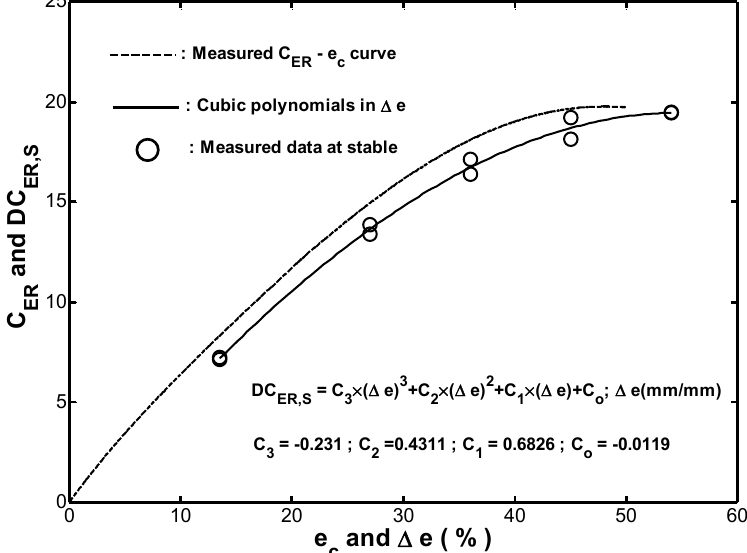
Figure 12. Comparison of measured C ER − e c curve, ( ∆ e , DC ER , S ) data at stable, and fitted Figure 12. Comparison of measured 𝐶 (cid:3006)(cid:3019) − 𝑒 (cid:3030) curve, ( ∆𝑒, 𝐷𝐶 (cid:3006)(cid:3019),(cid:3020) ) data at stable, and fitted 𝐷𝐶 (cid:3006)(cid:3019),(cid:3020) − ∆𝑒 curve. DC ER , S − ∆ e Figure 12. Comparison of measured 𝐶 (cid:3006)(cid:3019) − 𝑒 (cid:3030) curve, ( ∆𝑒, 𝐷𝐶 (cid:3006)(cid:3019),(cid:3020) ) data at stable, and fitted 𝐷𝐶 (cid:3006)(cid:3019),(cid:3020) − ∆𝑒 curve.